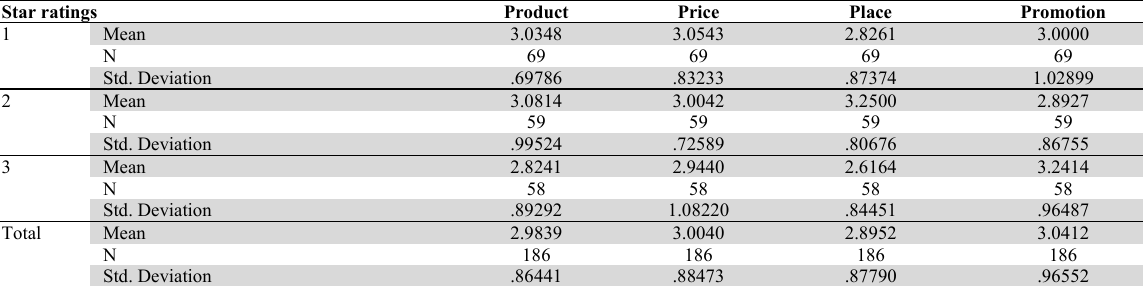
Table 3 indicates the averages and standard deviations for the fields of study (final product, price, location, and promotion) according to the classification of hotels in the Aqaba Special Economic Zone. And the four-star hotels got an average arith- metic average in terms of the final product, which reached (3.08) with a standard deviation of (0.99524). In three-star hotels the survey got the lowest arithmetic mean of (2.8241) with a standard deviation (0.89293). As for the price, the five hotels occupied Stars ranked first with a mean (3.0543) with a standard deviation of 0.833233 . As for the place, the four-star hotels got the highest average arithmetic score as well (3.2500) with a standard deviation (0.8067) and three-star hotels got the lowest arithmetic mean (2.6164) with a standard deviation (0.89770) and finally in terms of promotion, the three stars got. The